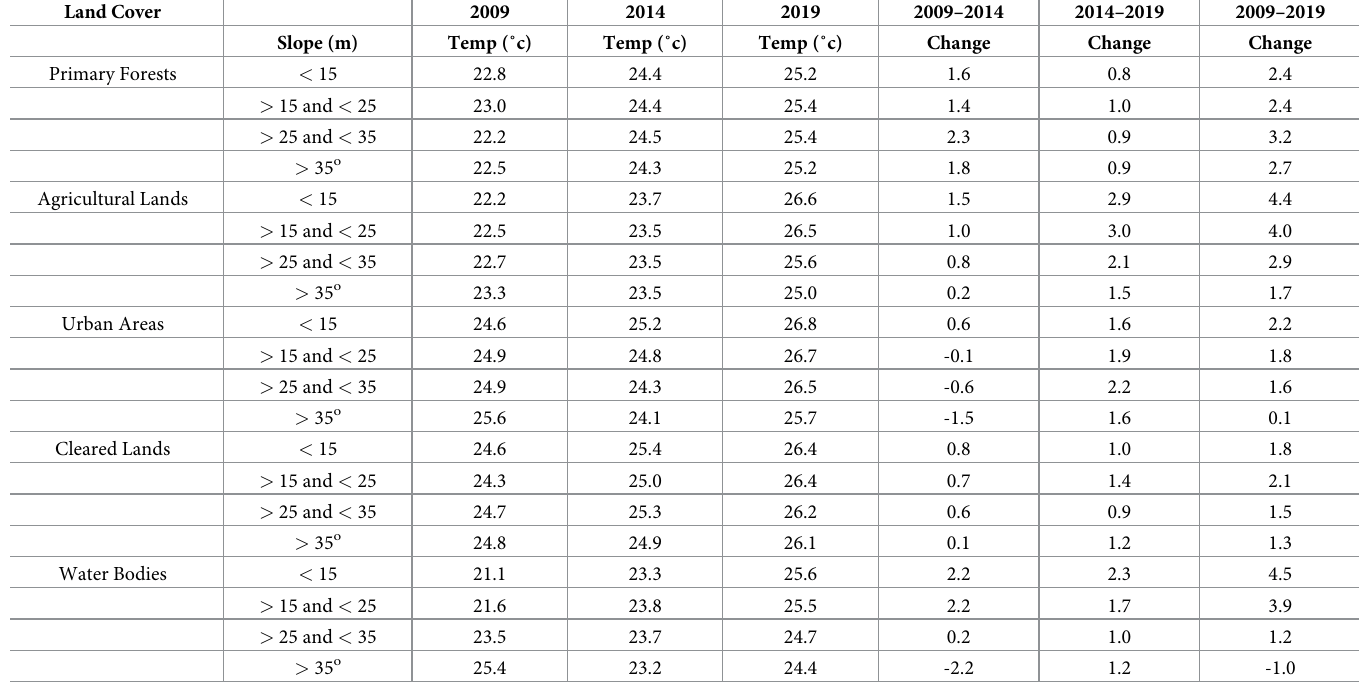
Table 9. LST trend per land cover–slope group.